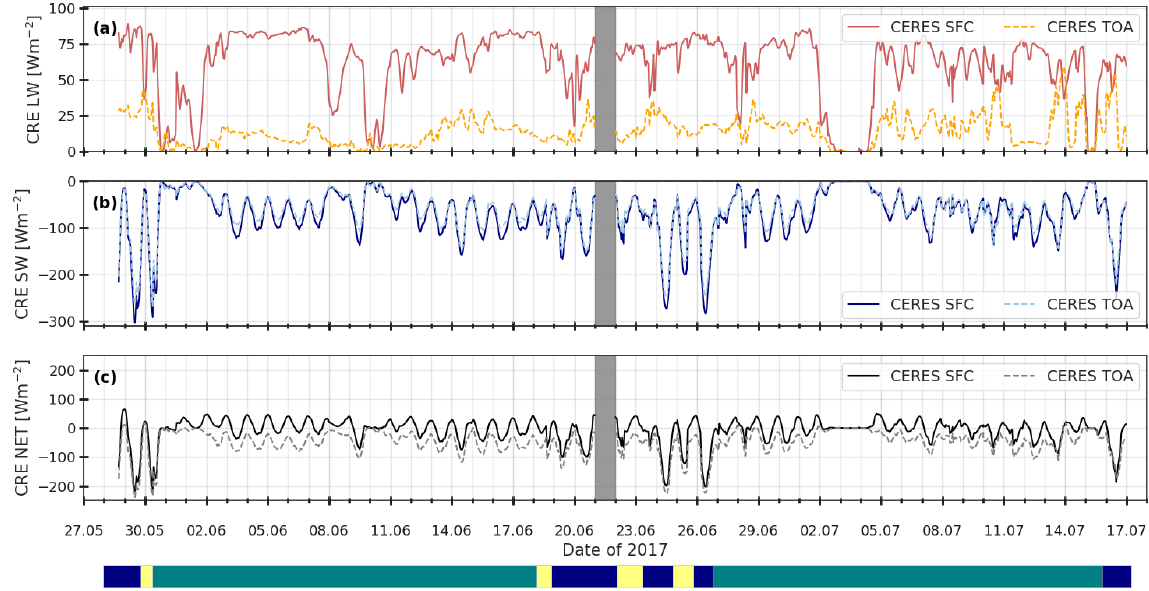
Figure 16. Time series of the cloud radiative effect (CRE) for the cruise track of the PS106 expedition based on CERES SYN1deg fluxes. Panel (a) shows the LW CRE at the surface (SFC) and top of the atmosphere (TOA). Panel (b) shows the SW CRE at the SFC and TOA, and panel (c) shows the net CRE at the SFC and TOA. The lower coloured band indicates the times when Polarstern was located in open ocean (blue), the marginal sea-ice zone (yellow) and in mostly sea ice (teal). Table 3. The table indicates the averaged results of the cloud radiative effect (CRE) for the LW, SW, and net fluxes based on CERES SYN1deg for the PS106 cruise and the entire Arctic. The standard deviation is given in parentheses. PS106 Arctic